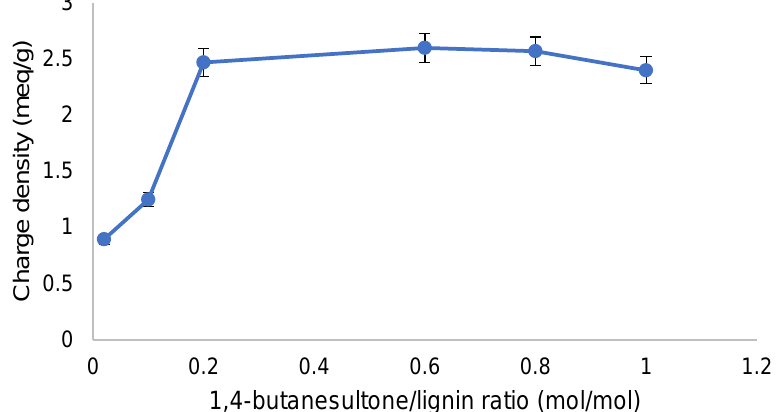
Figure 2. Effect of 1,4–butanesultone to lignin molar ratio on the charge density of sulfobutylated kraft lignin.